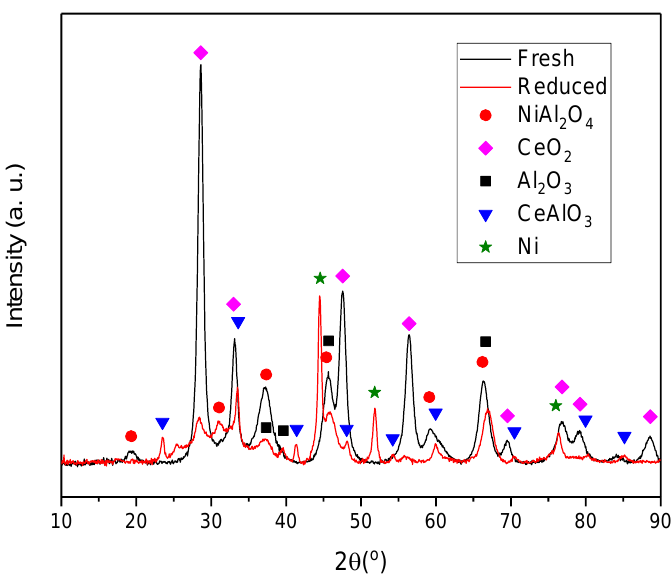
Figure 4. XRD profiles of the fresh and reduced Ni-Sn/CeAl catalyst.